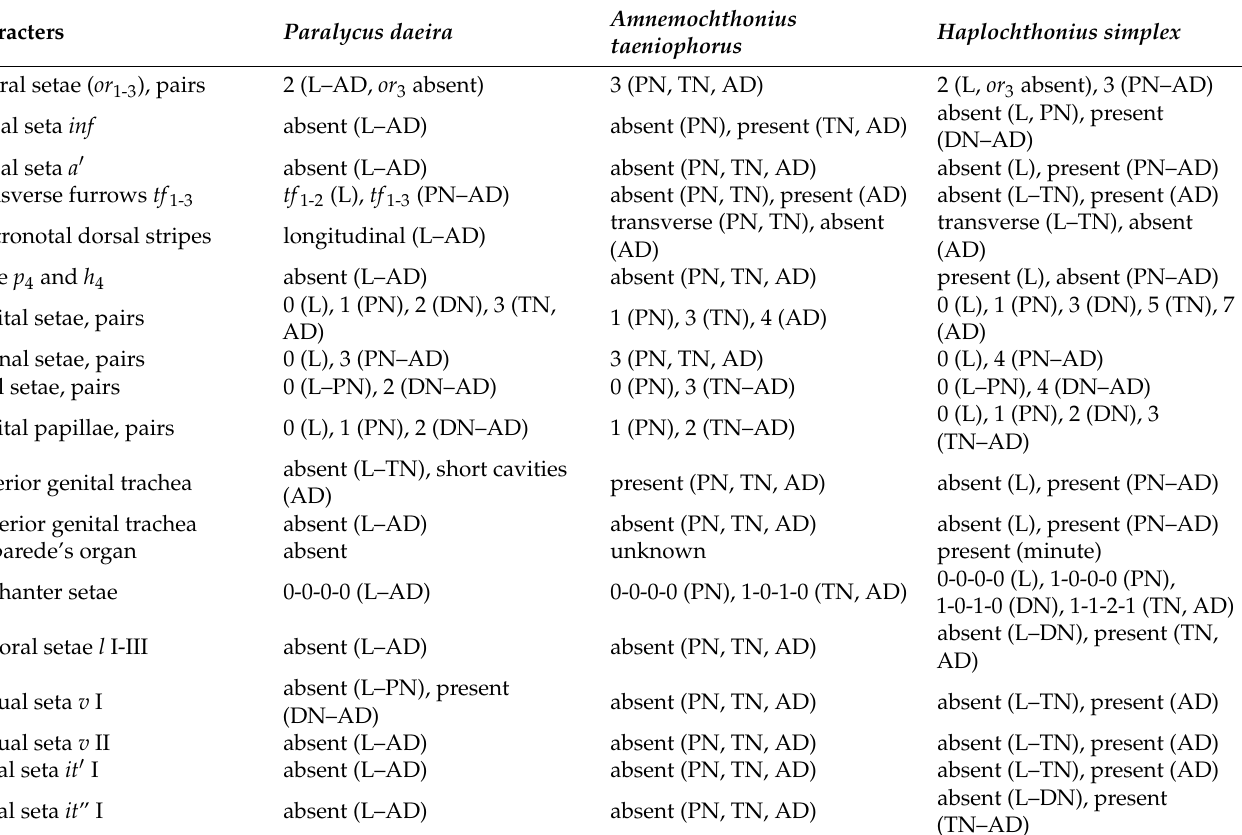
Table 3. Ontogeny of three species of Enarthronota. For Amnemochthonius taeniophorus , larvae and deutonymphs are